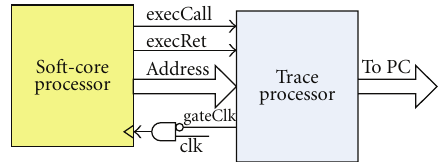
Figure 12: Hardware transparent instrumentation.